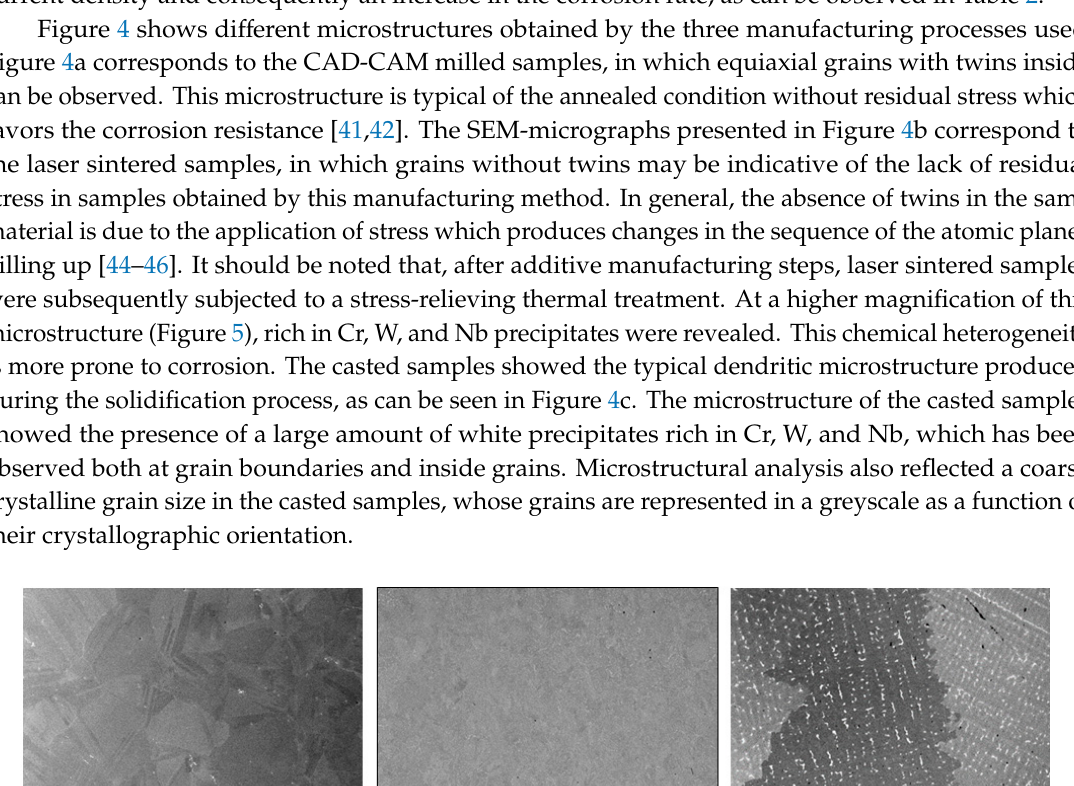
Figure 5. SEM micrograph of laser sintered sample with details of EDS-microanalysis of both the matrix and precipitates.